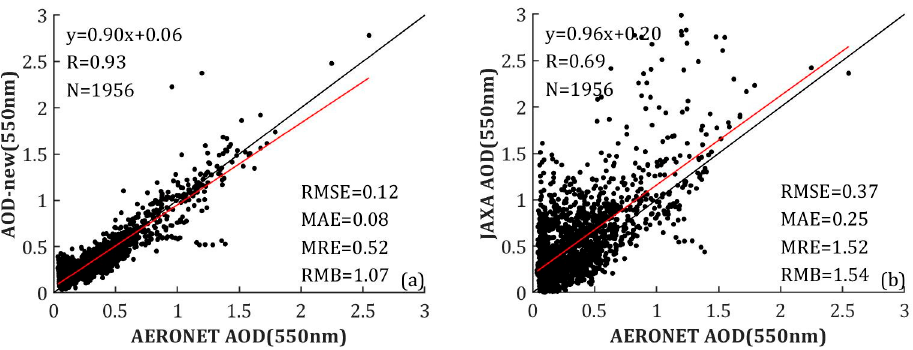
Figure 6. Scatter plots of AOD-new versus AERONET AODs ( a ) and JAXA AODs versus AERONET AODs ( b ). The black and red solid lines are the 1:1 line and regression line, respectively. The bias between the satellite-retrieved AODs (AOD-new and JAXA AOD) versus AERONET AODs, varying with the AOD, is shown in Figure 7, in which all matchup samples have been divided into 10 bins with 200 samples in each bin (156 samples in the 10th bin). As shown in the Figure 7a, the bias of the AOD-new decreases with increase of the AERONET AOD when the AERONET AOD is smaller than 0.5. Figure 7b shows the bias between the JAXA AOD versus the AERONET AOD. Large biases and uncertainties are found at all aerosol loadings situation. Both the AOD-new and JAXA AODs show overestimation when the atmosphere is clean, but the bias of AOD-new is much smaller than that of JAXA AOD. Figure 7c,d is the same as Figure 7a,b, but varying with satellite- retrieved AODs. Figure 7c shows that the bias of AOD-new does not significantly vary with the increase of the AHI AOD and that there is slight overestimation over the area with high retrieved value. Compared with the bias of AOD-new, the bias of JAXA AOD, shown in Figure 7d, varies more dramatically, almost showing a linear increase trend with the increase of the JAXA AOD.